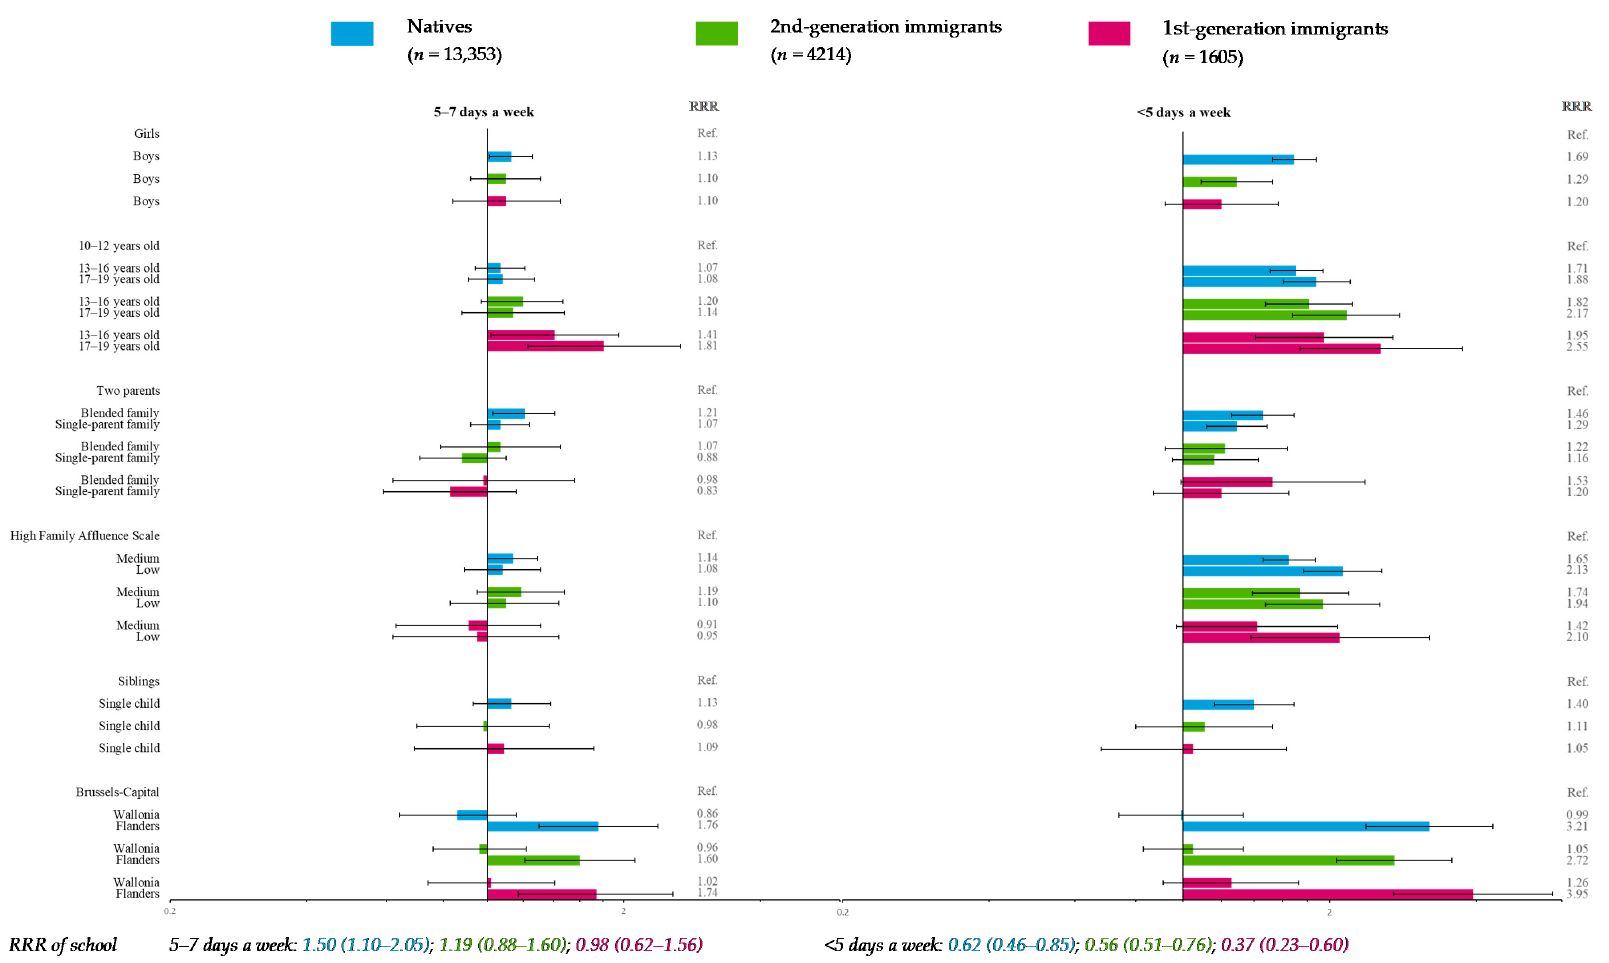
Figure 3. Multiple multilevel multinomial regression* for fruit consumption (reference category: >once a day) stratified by migration status—HBSC, Belgium, 2014 ( n = 19,172). * RRR < 1: More favorable for health; RRR > 1: Less favorable for health.